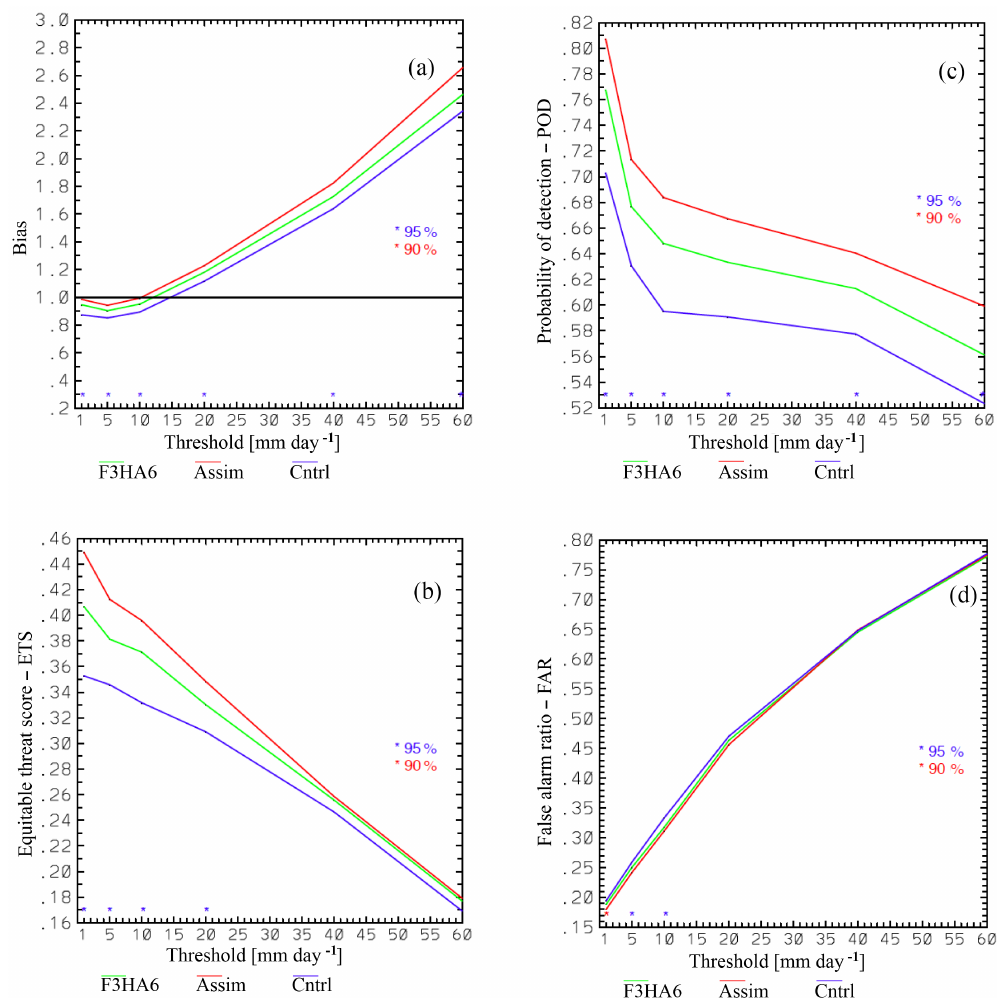
Figure 8. Scores for the daily precipitation computed by summing the contingency tables of all 20 case studies: (a) bias (the line of the perfect score 1.0 is shown in black); (b) equitable threat score; (c) probability of detection; (d) false alarm ratio. F3HA6 is in green, ASSIM is in red, and CNTRL in blue. The asterisks above the x axis show the results of the hypothesis testing (95% blue, 90% red) of the difference between F3HA6 and CNTRL